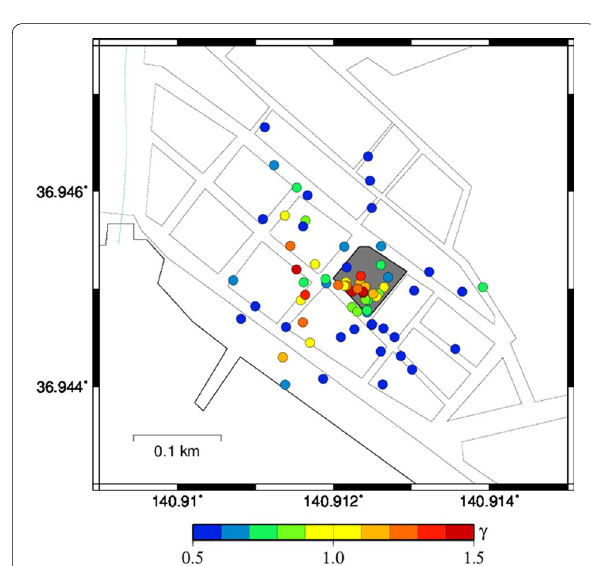
Fig. 9 Comparison of directionally dependent coefficient γ of MHVRs in the frequency range of 1 to 6 Hz for points on Line-A to Line-I and Line-3 to Line-4. A higher value of γ indicates a stronger directional dependence. In particular, the difference is noticeable if γ exceeds 0.7, and the difference is significant if γ exceeds